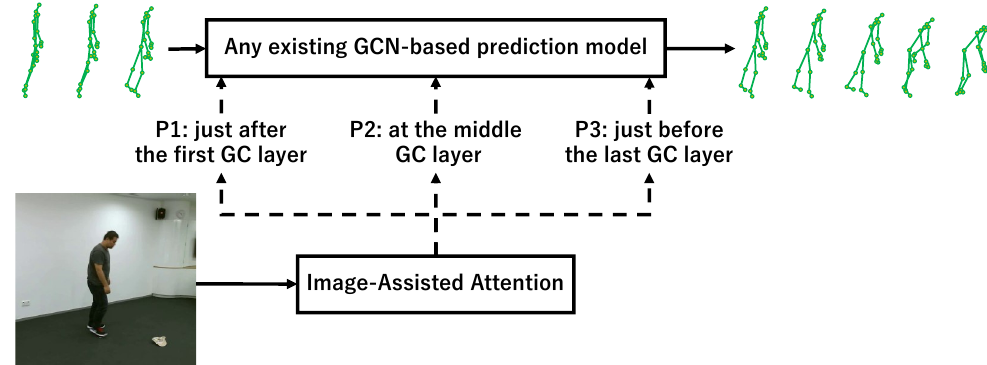
Figure 4. The three locations where the IAA module is inserted into any existing GCN-based model. P1 is the initial stage of the feature extraction, P2 is the end of the feature extraction, and P3 is the final stage of the generating